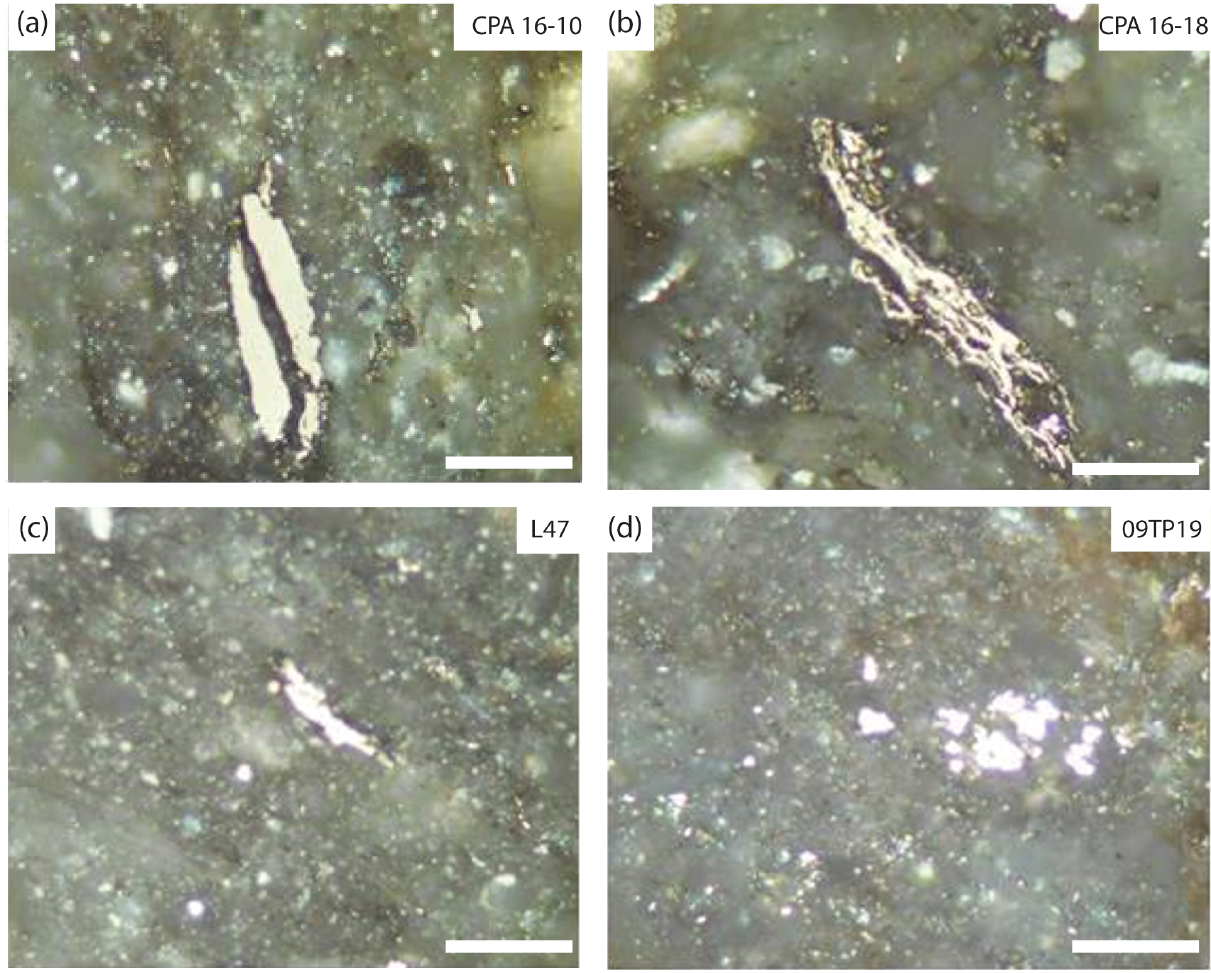
Figure 3. Carbonaceous matter from the Torres del Paine intrusion in reflected light microscopy. (a–d) Individual samples, labeled in the top right corners, ordered by increasing metamorphic degree. Scale bars equal